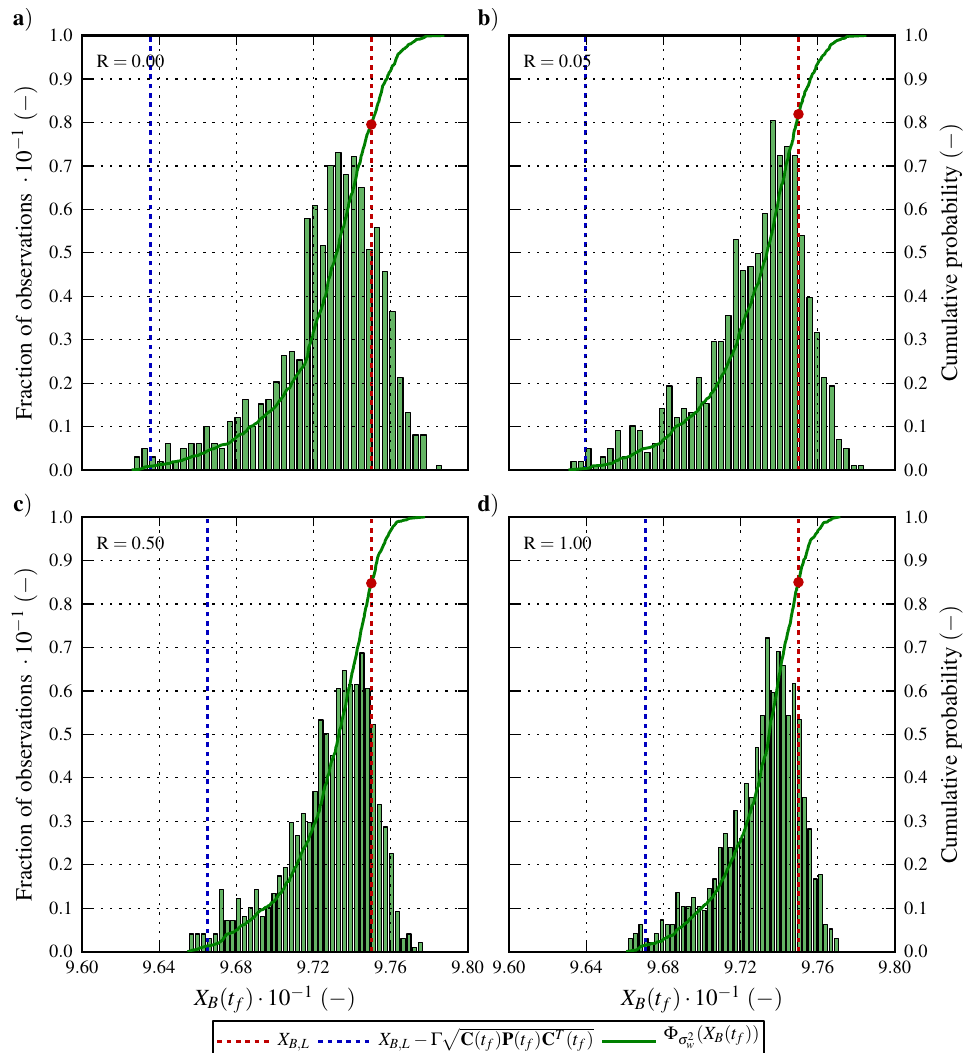
Figure 13. Probability distribution of the variability in X B ( t f ) generated with the set of stochastic control signals, ˜ u , sampled from a uniform distribution with the uncertainty level σ = 5 . 0%. The dashed lines indicate the lower purity constraint, X w C ( t ) P ( t ) C T ( t ) . The solid line indicates the cumulative worst-case purity, X B , L Γ f f f − ( X ( t )) probability, Φ B f σ 2 (cid:112) w